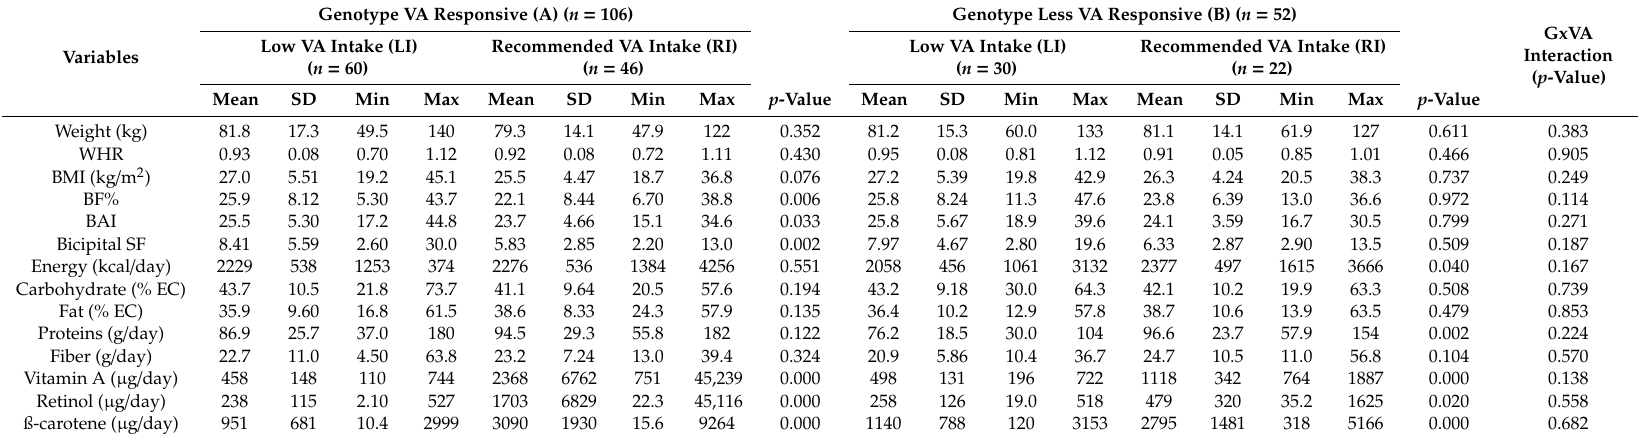
Table 2. Anthropometric and dietary parameters by genotype group (A, Responsive to VA; B, Less responsive to VA) and Vitamin A (VA) intake level